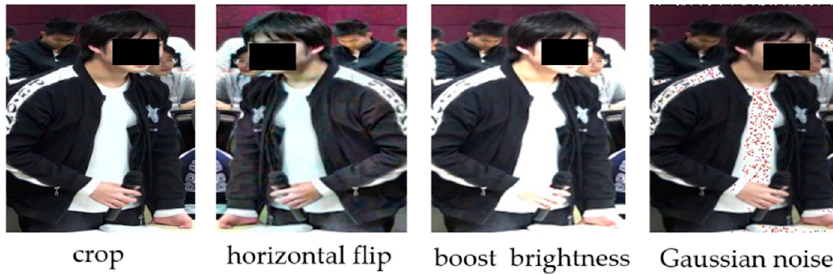
Figure 13. Data enhancement effect.